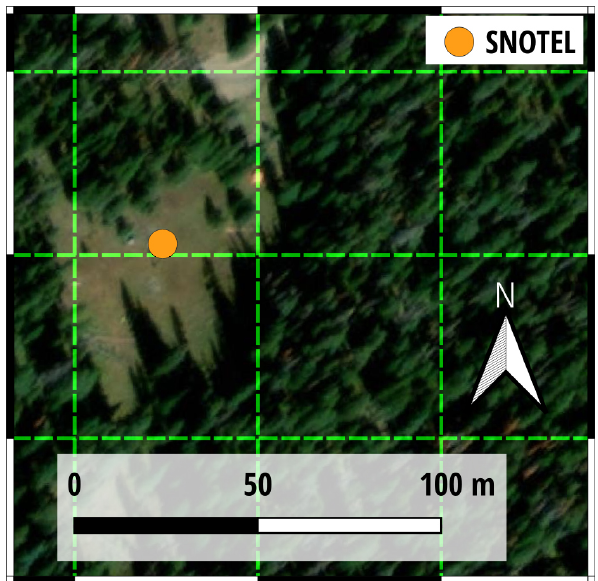
Figure 3. SNOTEL Schofield Pass site location relative to the con- figured model output resolution of 50m (green-dashed grid). No site was centered in one pixel, and a spatial 2 × 2 grid surrounding the site was used for simulated HRRR-iSnobal comparison values. Basemap: ©